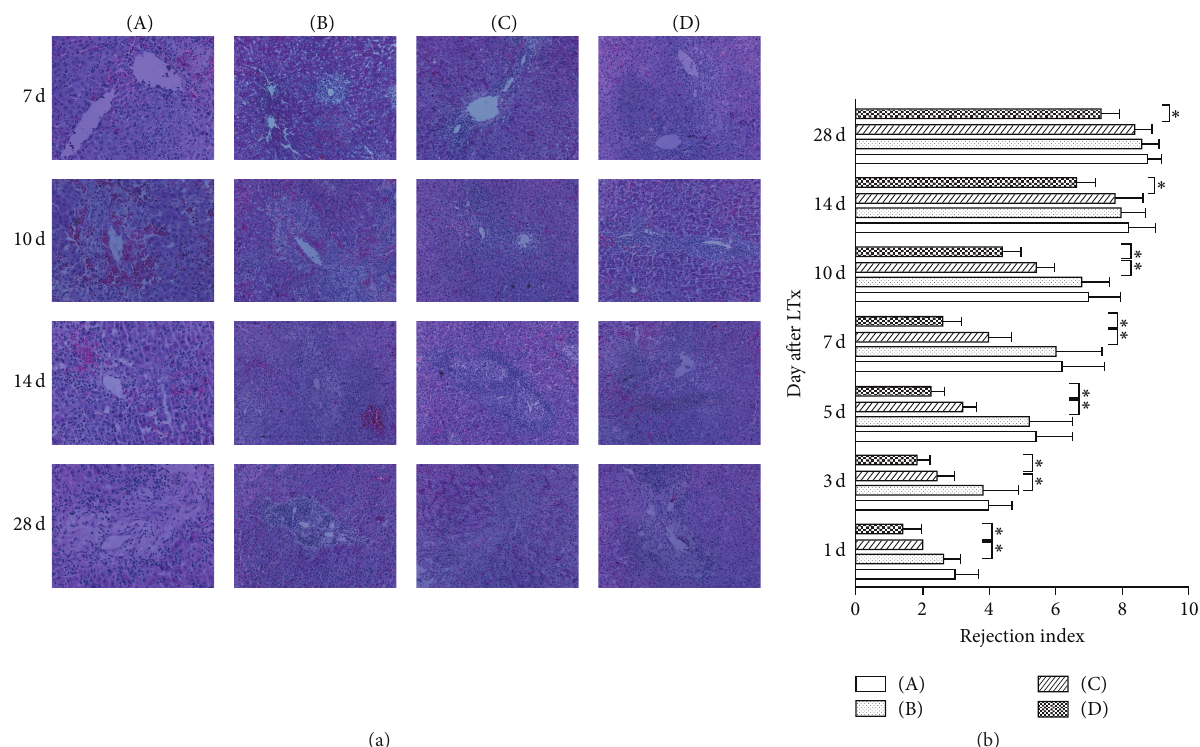
Figure 3: Histological sections of the rat liver and grading of ACR after LTx. (A) Normal saline group; (B) HO-1 group; (C) BMMSCs group; (D) HO-1/MSCs group. (H&E staining, 100x). (a) In the normal saline and HO-1 groups, ACR grading on day 7 was moderate to severe, with abundant mixed lymphocytes in the portal area, interlobular bile duct inflammation and damage, inflammatory cell infiltration in the vein area, and necrosis of liver cells. In the BMMSCs group, ACR grading was mild until day 7, was aggravated sharply after day 7, and was moderate to severe on day 14. ACR was attenuated in the HO-1/MSCs group and decreased at all time points, compared to control groups ( ∗ 𝑃 < 0.05 ). (b) Histogram of ACR grading ( 𝑛 = 5 in each group, the HO-1-transduced BMMSCs group compared to control groups). Data are expressed as the mean ± SD ( ∗ 𝑃 < 0.05